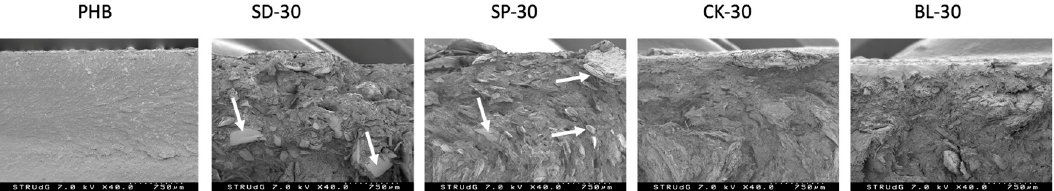
Figure 9. SEM observation of the breaking area of samples testes under tensile stresses. White arrows identify particles of the reinforcement.